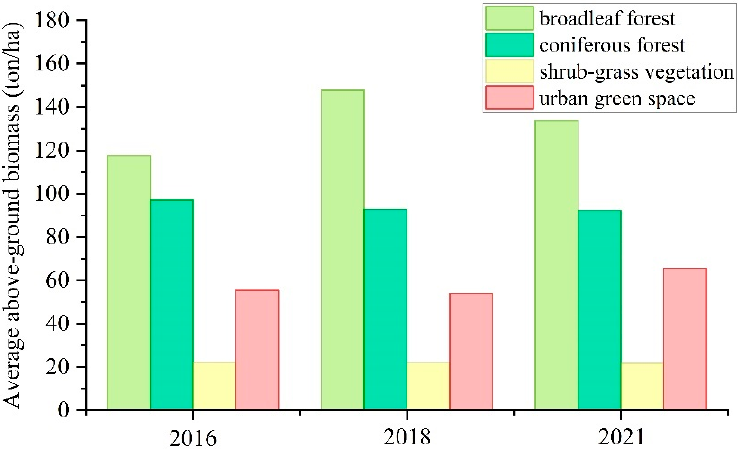
Figure 9. Variation in the average AGB of UGS by category.